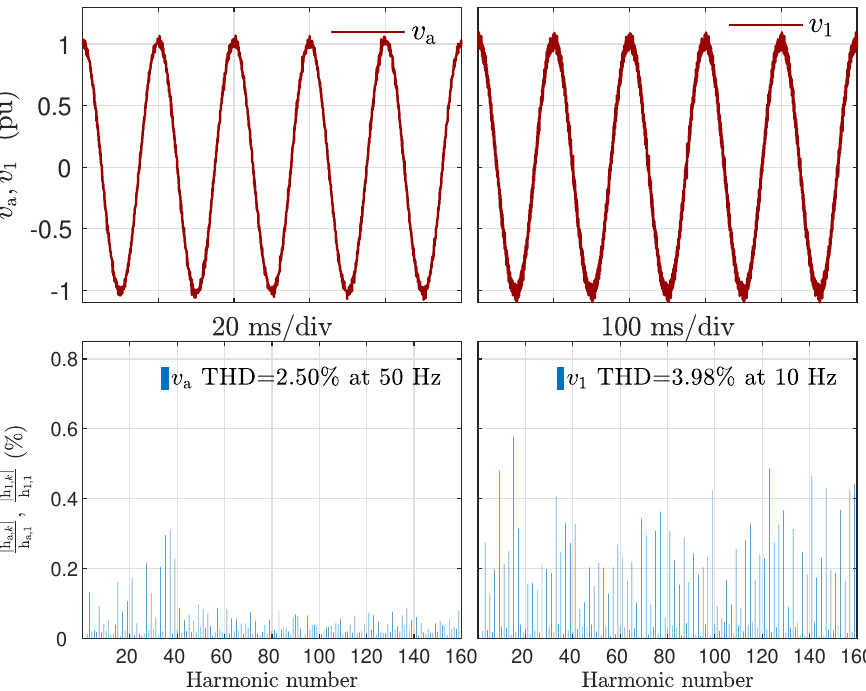
Figure 22. Spectrum of v a , v 1 and THD results when PD–SPWM modulation technique is